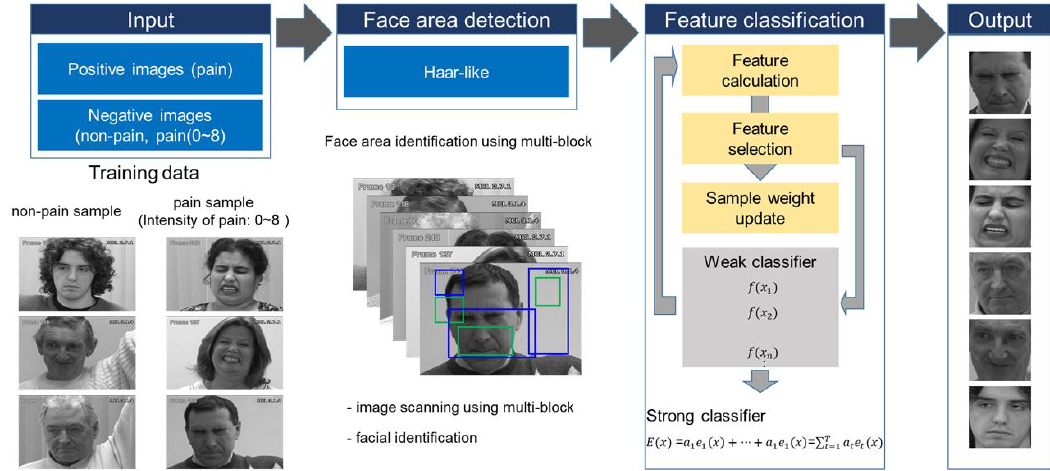
Figure 3. The multiple AdaBoost-based particular facial area detection process.